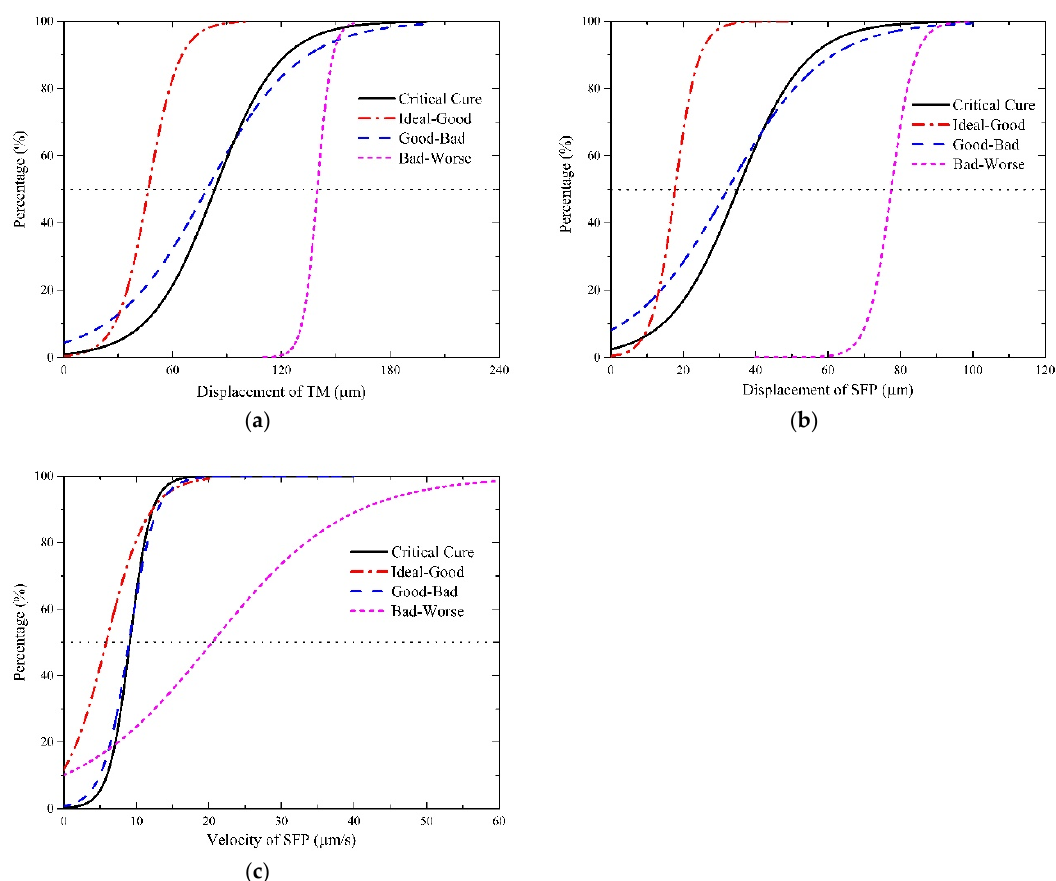
Figure 4. Relationship between risks of the aural discomfort level and the exposures of the indicators.